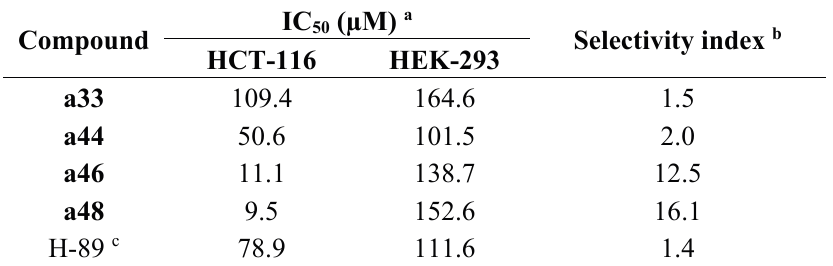
Figure 6. Chemical structures of Compounds a33 , a44 , a46 and a48 . Table 1. Cytotoxicity (IC 50 values) of Compounds a33 , a44 , a46 and a48 against human colon cancer cells (HCT-116) and normal human embryonic kidney cells